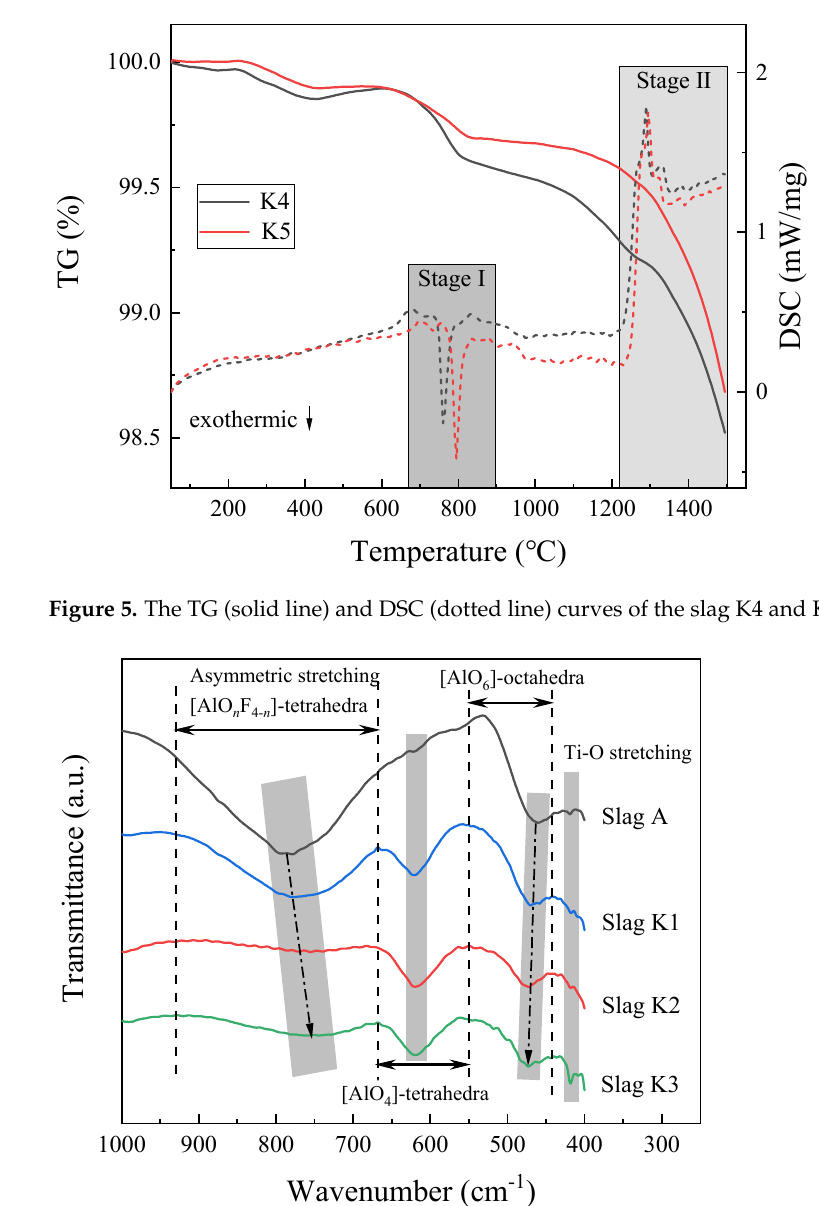
Figure 6. FTIR spectra for the slags with different K 2 O content: slag A, 0 wt% K 2 O; slag K1, 2.3 wt% K 2 O; slag K2, 5.3 wt% K 2 O; slag K3, 8.3 wt% K 2 O. K 2 O; slag K2, 5.3 wt% K 2 O; slag K3, 8.3 wt% K 2